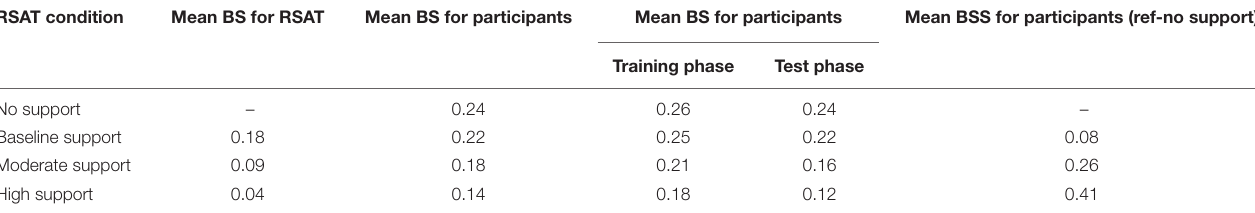
TABLE 3 | Group-wise mean brier score and brier skill scores.